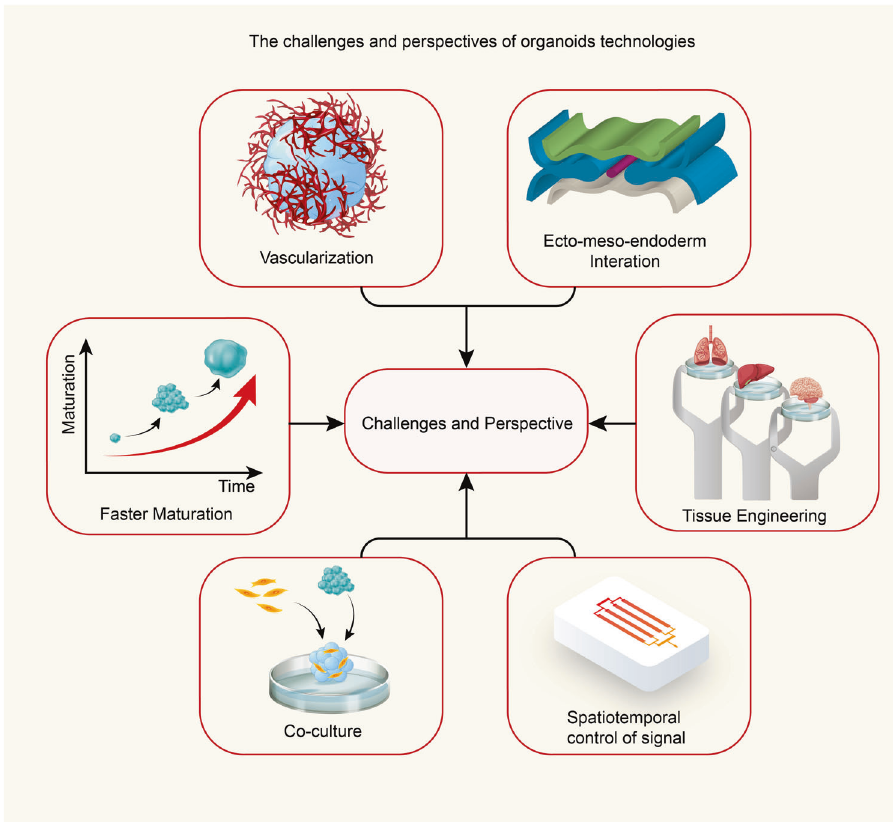
Fig. 6 Challenges and perspectives of organoid technologies. View of the challenges and perspectives of organoid technologies. Speci fi cally, the sizes of the organoids developed to date have been limited due to the lack of vascular structures, but implementation of vascularization via coculture with endothelial cells could provide a near-physiological way to increase nutrient exchange. Slow maturation is another crucial factor limiting the disease modeling of later developmental stages, but pretreating organoids with small molecule compounds may be a solution to this hurdle. Moreover, establishment of ecto-, meso-, and endoderm tissue interactions during development may be a promising approach to improve recapitulation of the typical organ system interactions observed in vivo. Tissue engineering could control over the materials and the precise apportion of different cell types through kinds of biofabrication techniques, it is also a promising approach to using micro fl uidic platform in composite organoids. Coculture systems could offer the advantages of 3D organoid model systems to study functional and/or temporal and spatiotemporal interactions among diverse cell populations. Following the principles of organogenesis during the embryonic developmental stage, the regulation of cell differentiation in space and time can be directly controlled in vitro via implementation of concentration gradients and signaling centers of shape-guided